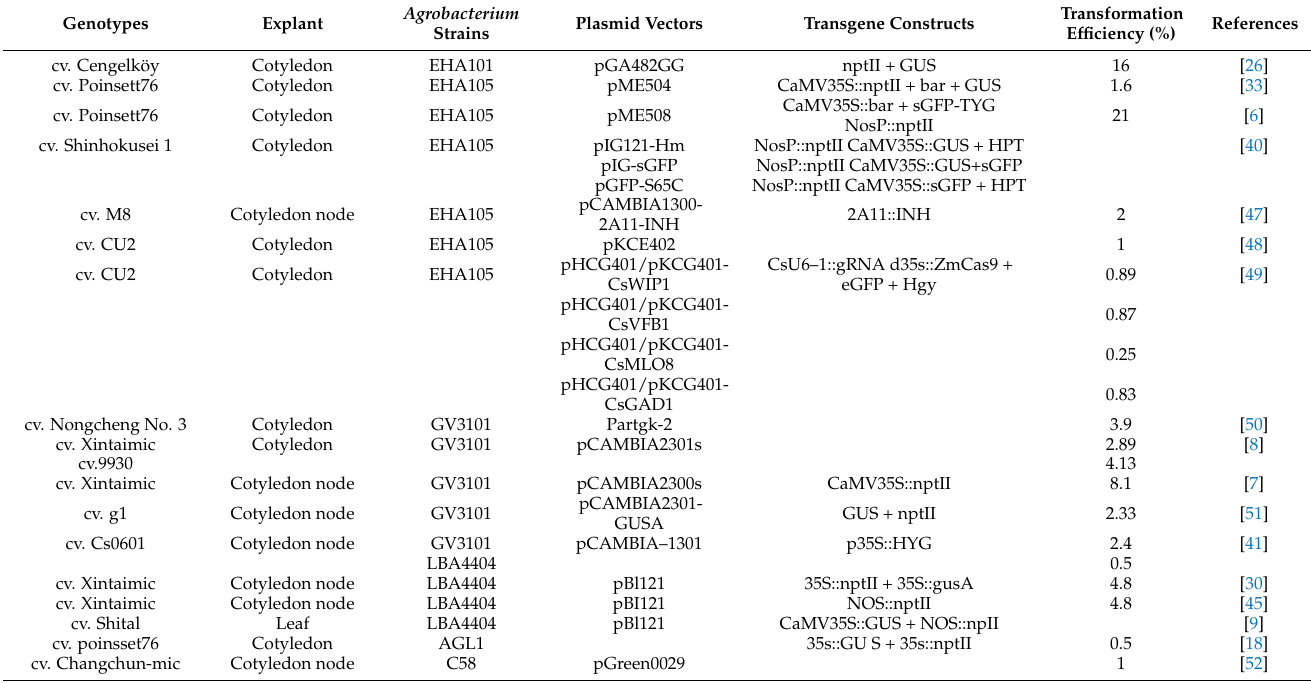
Table 2. Details of some successful reports on Agrobacterium -mediated transformation of